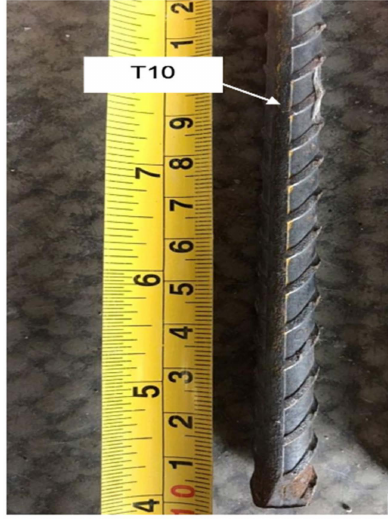
Figure 3. The high yield steel’s T10.